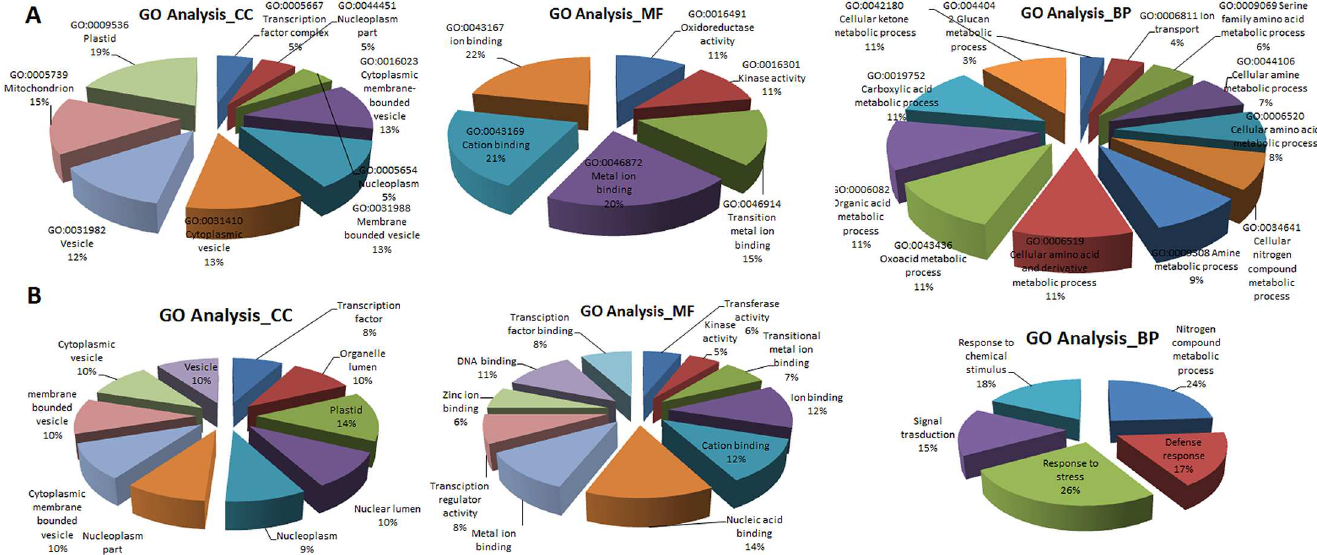
Fig 2. Functional enrichment analysis of selected genes and hub genes under Al stress. The GO term enrichmentanalysisof 981 selected informative genes(A) and hub genes (B) for Al stress conditionusing Agrig ois shown for different gene ontologycategories(CC, MF and BP). For (A), the GO terms are chosen whosep-values < 0.008 and FDR values (false discovery rate) < 0.6. For (B), the GO terms are chosen whose p-values < 0.1 and FDR values < 0.8.